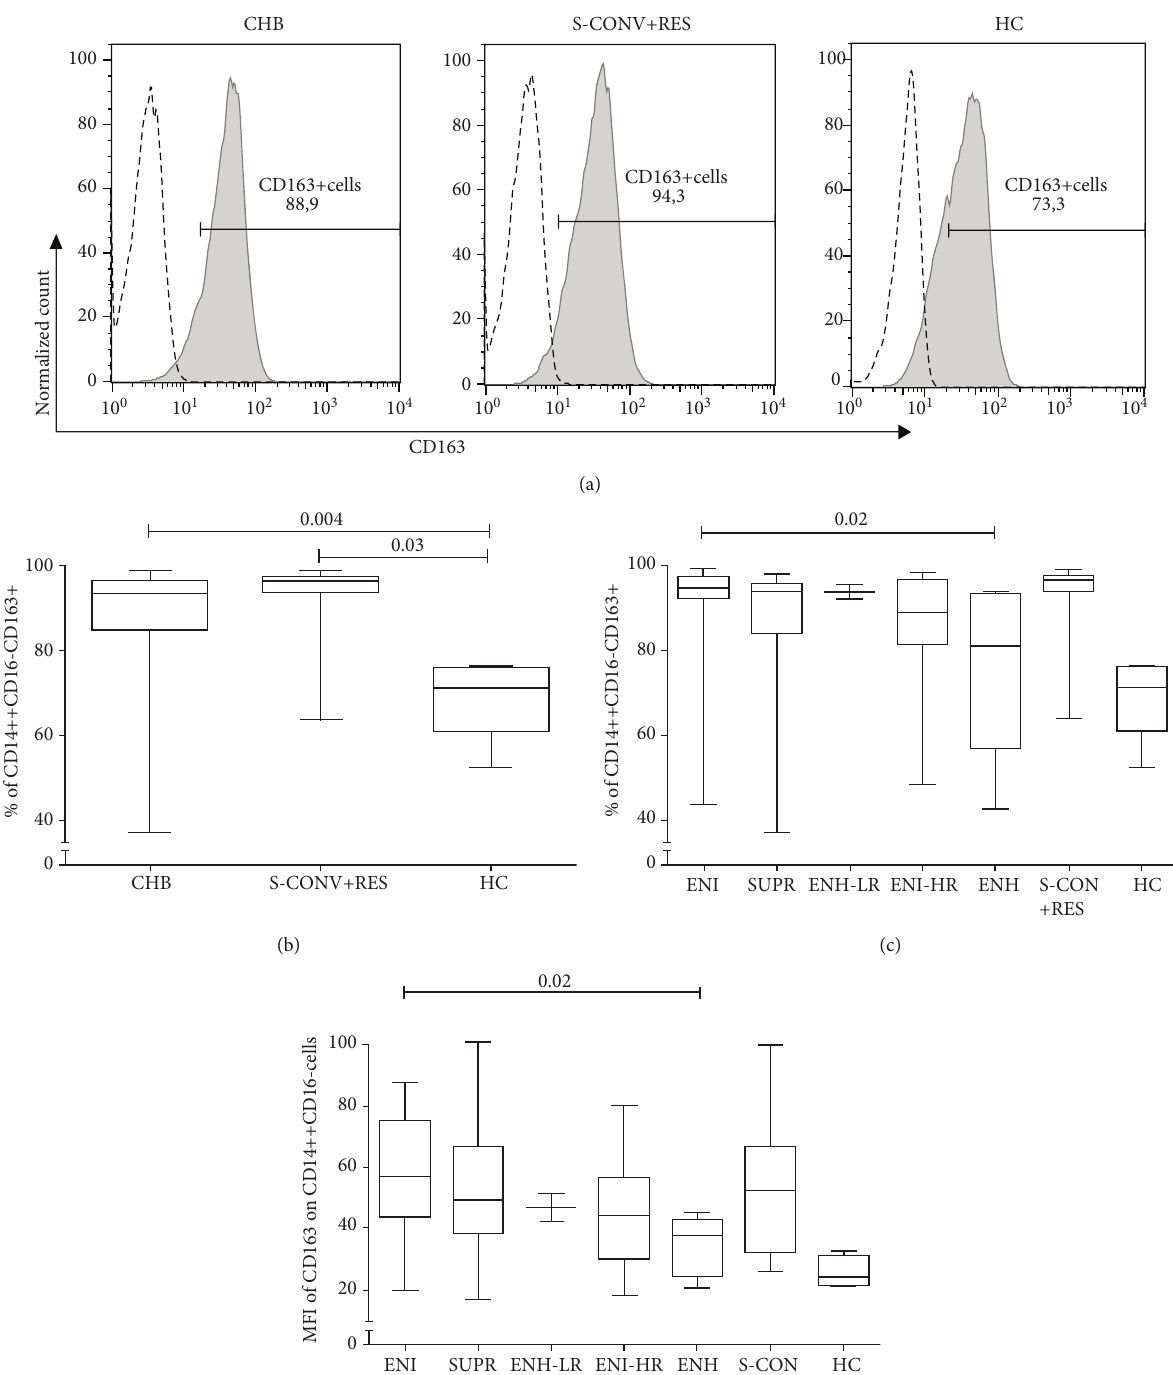
Figure 2: Frequency and expression of CD163 within classical monocytes. (a) Representative histograms showing CD163 expression in CHB, S-CONV+RES, and HC groups (solid lines), with adequate FMO controls (dashed lines). (b) Comparative analysis of CD163 expression on classical monocytes in CHB, S-CONV+RES, and HC groups. (c, d) Comparative analysis of CD163 expression on classical monocytes with reference to the phase of CHB infection. Data presented as median values with 25 th and 75 th percentile and minimum-maximum